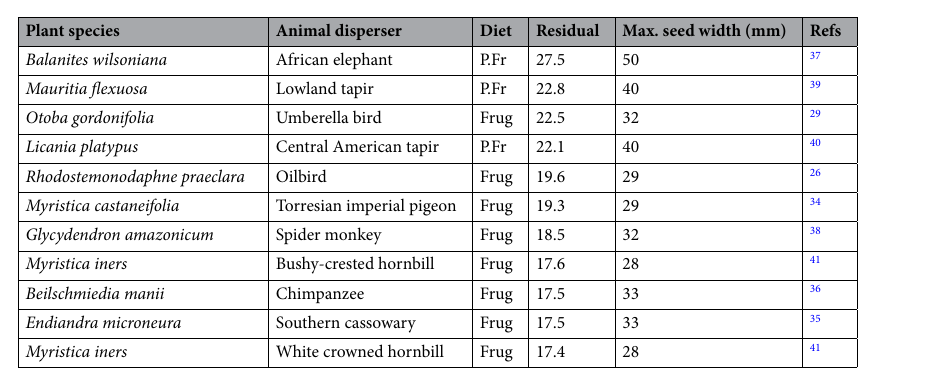
Table 1. List of species showing the largest positive residuals in the relationship between maximum seed width and body weight. The list includes frugivores (Frug) and partially frugivorous animals (P. Fr).